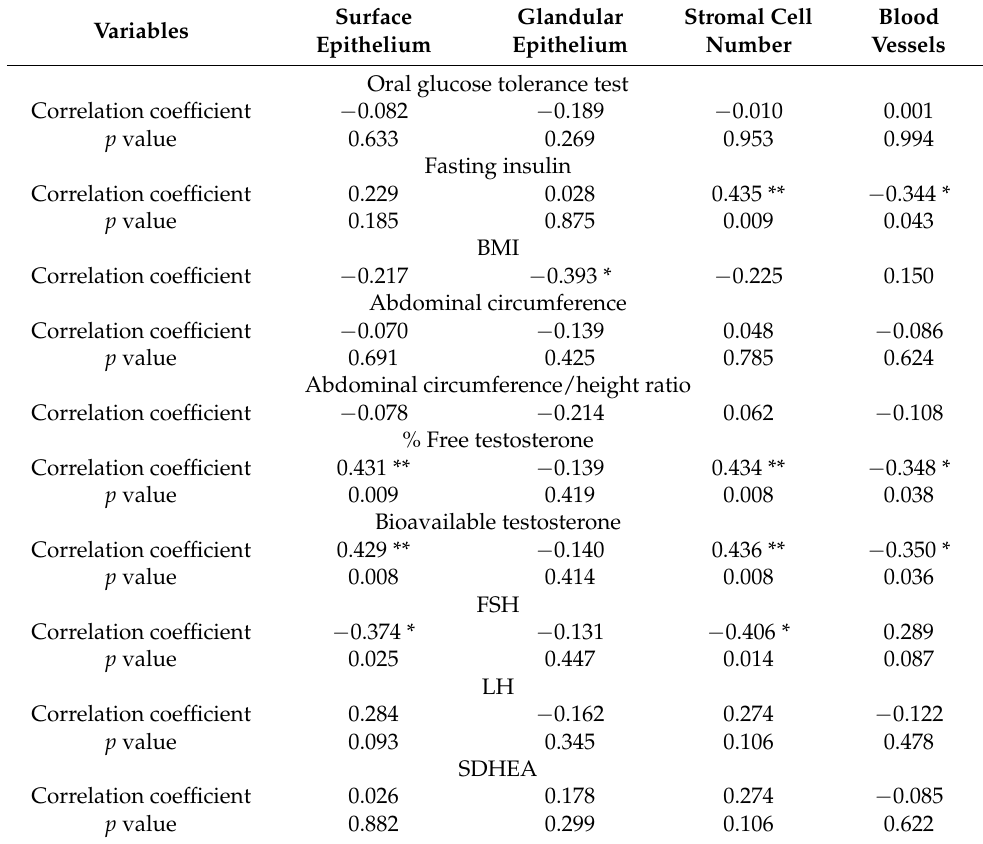
Table 4. Correlation between the histomorphometric findings of hirsutism and the clinical and hormone measurements according to the histomorphometric